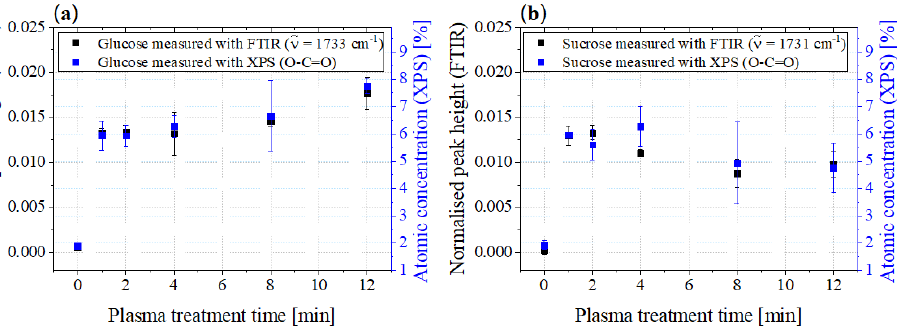
Figure 10. Comparison of the peak height courses of the newly formed bands of the carbonyl compounds in the FTIR spectra with the atomic concentrations of the O-C=O bonds of ( a ) glucose and ( b ) sucrose determined via